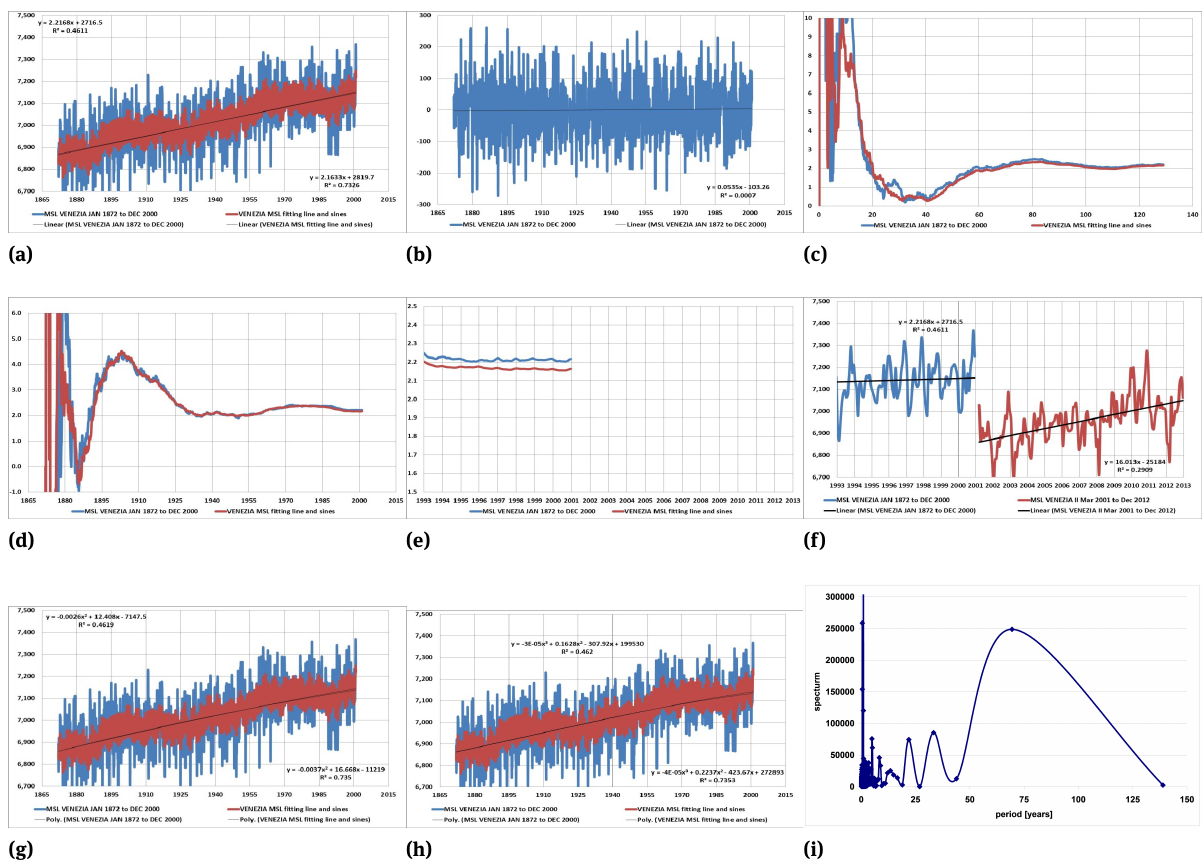
Fig. 3. Venice tide gauge results: a) is the measured MSL with gaps filled and fitting with a line and sines; b) is the residual of the fitting with a line and sines; c) is the present rate of rise of sea level by using different record length; d) is the time history of the rate of rise from all the data up to a specific time; e) is the same of d) with zoom on the last two decades of the satellite altimetry; f) is the measured MSL of the historical and recent stations; g) is the parabolic fitting of the measured MSL with gaps filled; h) is the cubic fitting of the measured MSL with gaps filled; i) raw periodogram of the monthly average mean sea level results with gaps